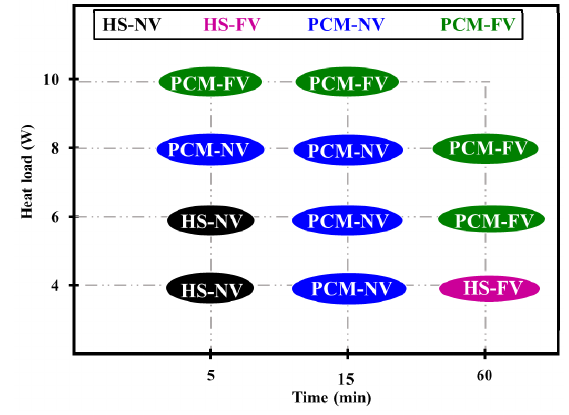
Figure 7. The optimum cooling techniques depending on operation time and heat load.